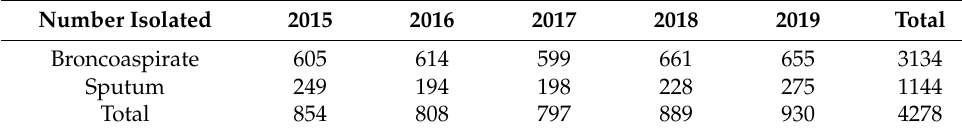
Table 2. The number of species isolated per type of positive sample.